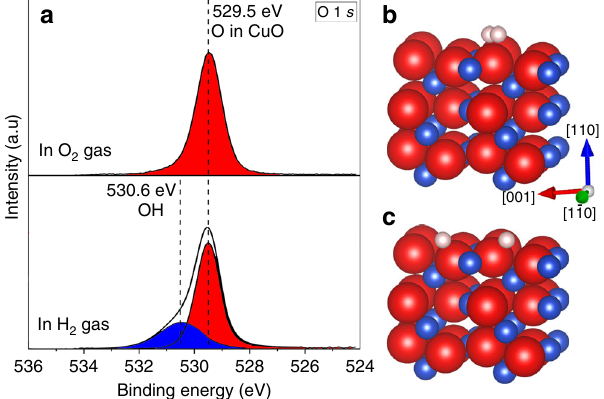
Fig. 5 AP-XPS measurements and DFT modeling of the reaction pathway. a Photoelectron spectra of O 1 s obtained from the CuO surface by oxidizing Cu at pO 2 ≈ 133 Pa and T = 350 °C (upper panel) and its subsequent exposure to 0.53 Pa of the constant fl ow of hydrogen gas at 300 °C (lower panel). The hydrogen exposure induces the broadening of the O 1 s spectrum to the higher binding energy side, where the major peak corresponds to lattice oxygen in CuO (red) and the shoulder is ascribed to the presence of surface hydroxyl groups (blue). b A H 2 molecule placed above the lattice O at the CuO ð (cid:1) 220 Þ surface, c DFT-relaxed structure showing the spontaneous dissociation of the H 2 molecule into two atomic H atoms that form two OH groups by bonding to adjacent lattice O. Blue, red, and pink balls represent Cu, O and H, respectively.